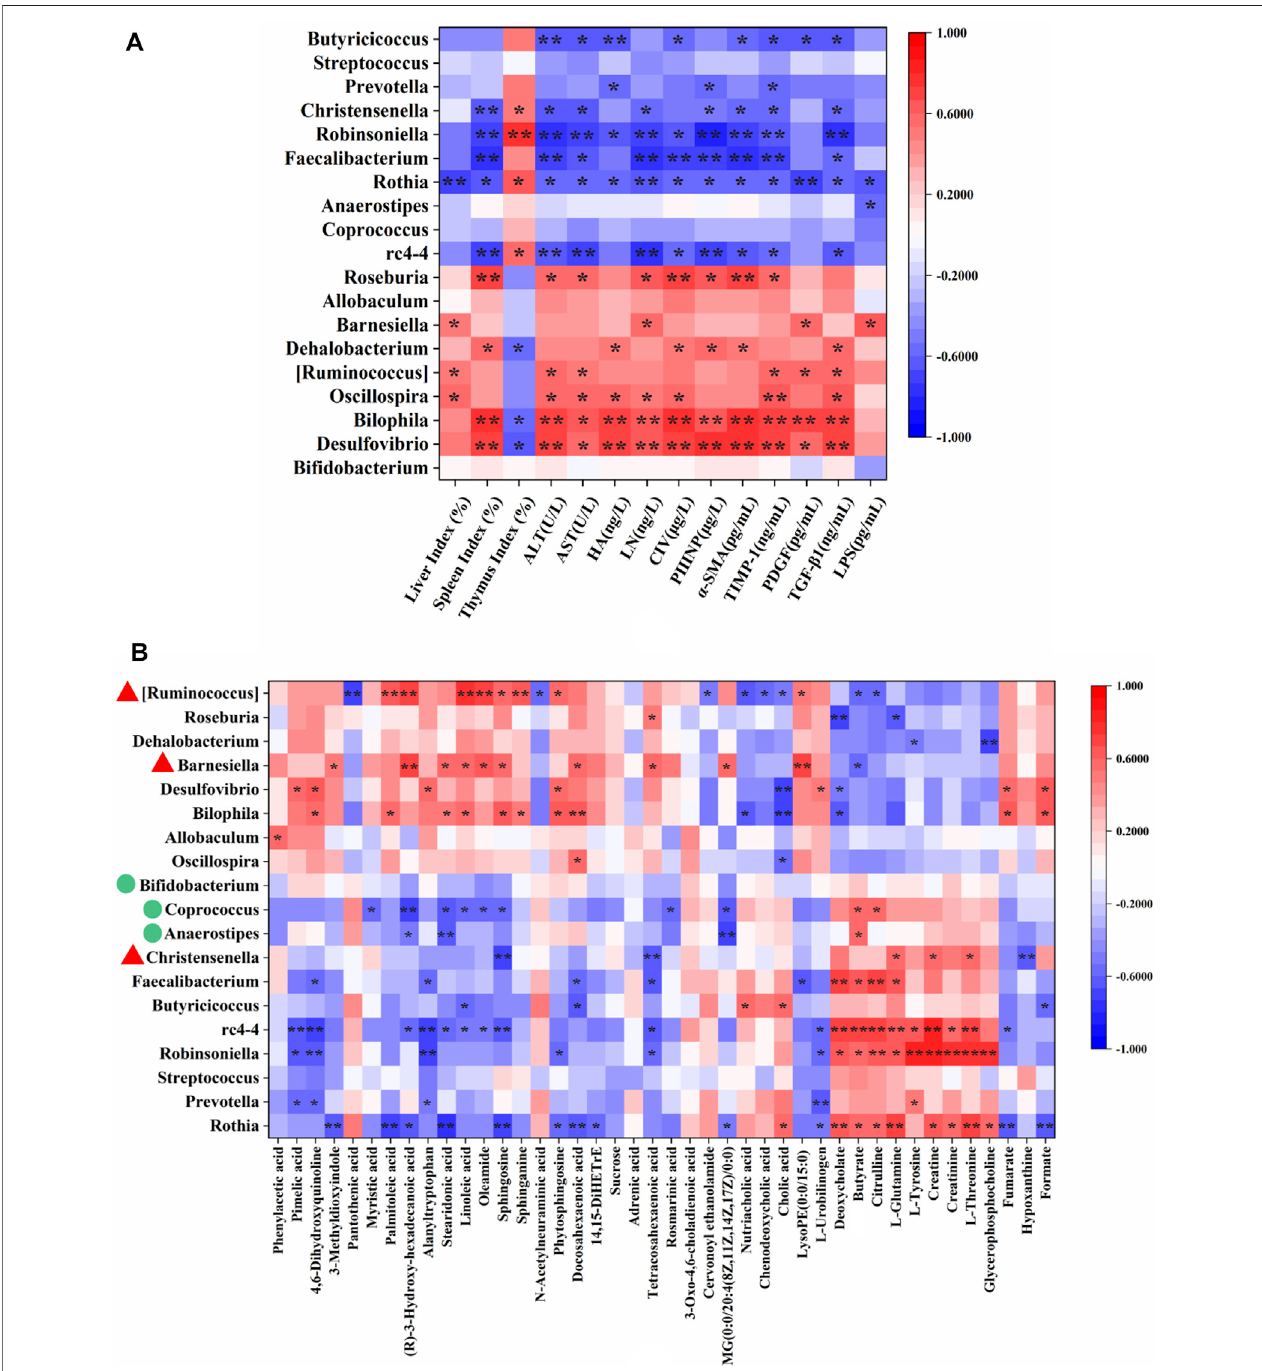
FIGURE 4 | Spearman ’ s correlation analysis of HF-related pathological indices, key fecal metabolites and signi fi cantly changed genera. (A) Correlations between 19signi fi cantlychangedgeneraand14HF-relatedpathologicalindices; (B) Correlationsbetween19signi fi cantlychangedgeneraand42keyfecalmetabolitesreversed byYCWLPtreatment.*|r| > 0.5and p -value < 0.05; ** |r| > 0.5and p -value < 0.01.Thegeneramarkedwithredtrianglesin (B) representthedisorderedHF-related genera reversed by YCWLP treatment. The genera marked with green circles in (B) represent the genera increased signi fi cantly after YCWLP treatment.